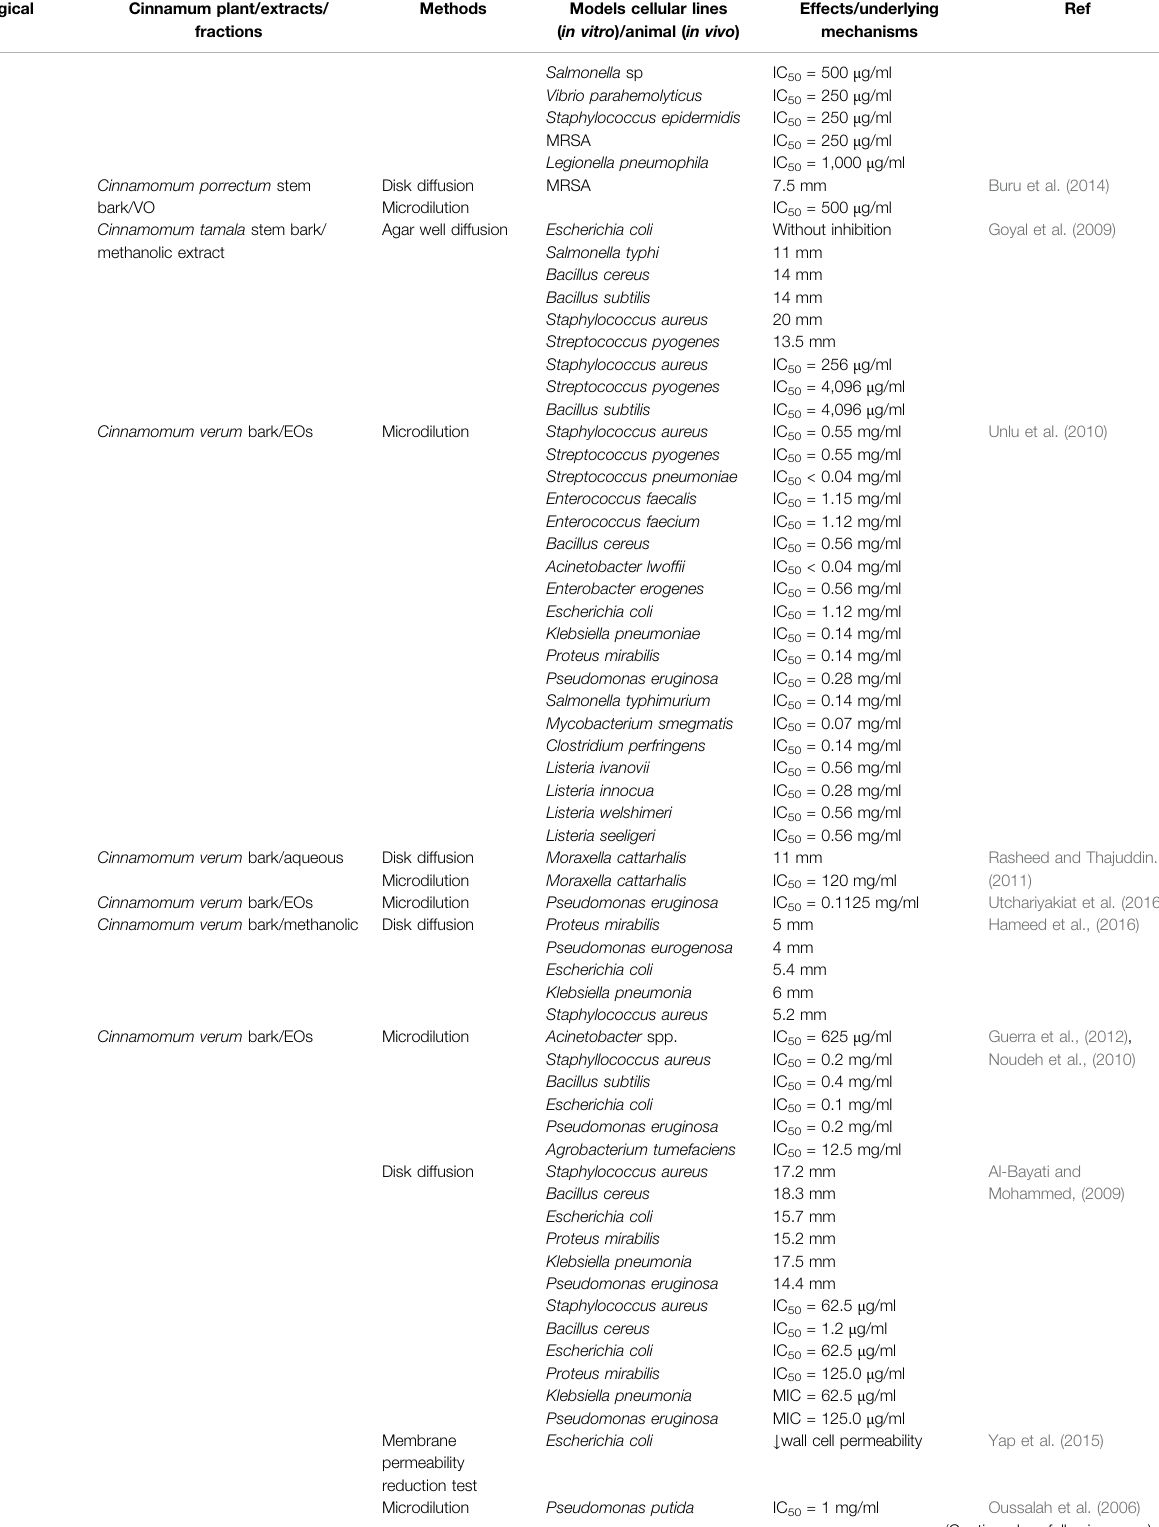
TABLE 2 | ( Continued ) Preclinical pharmacological activities of Cinnamomum genus. Pharmacological